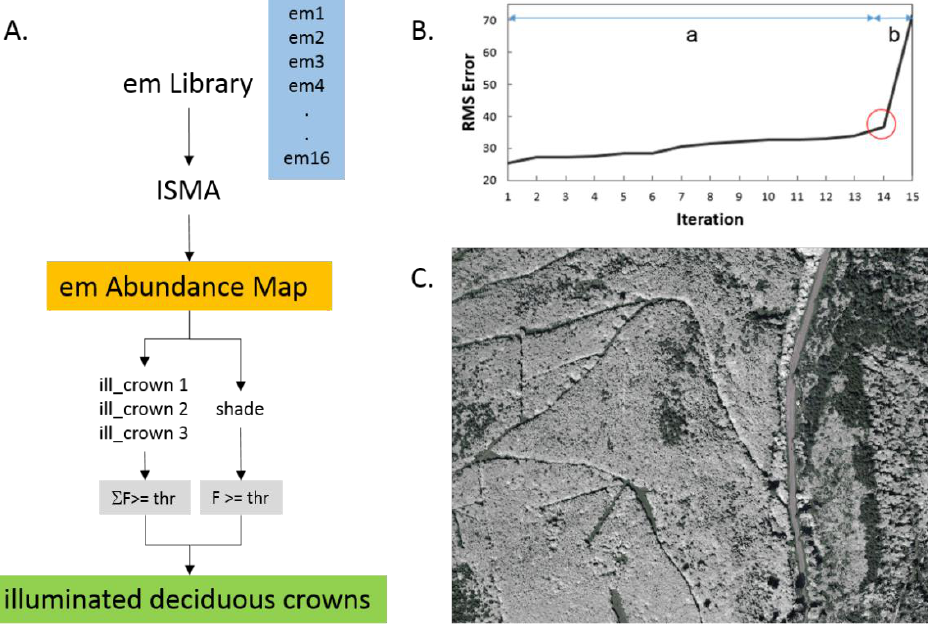
Figure 5. ISMA-based processing chain ( A ) to identify deciduous tree crowns. The identification of the correct endmember set is based on finding the “critical iteration” within the RMSE vector associated with the iterative elimination of spectral endmembers. The red circle marks the critical iteration after which the RMSE increases strongly ( B ). The grey areas in ( C ) are illuminated tree crowns, while the green areas mark the occurrence of coniferous